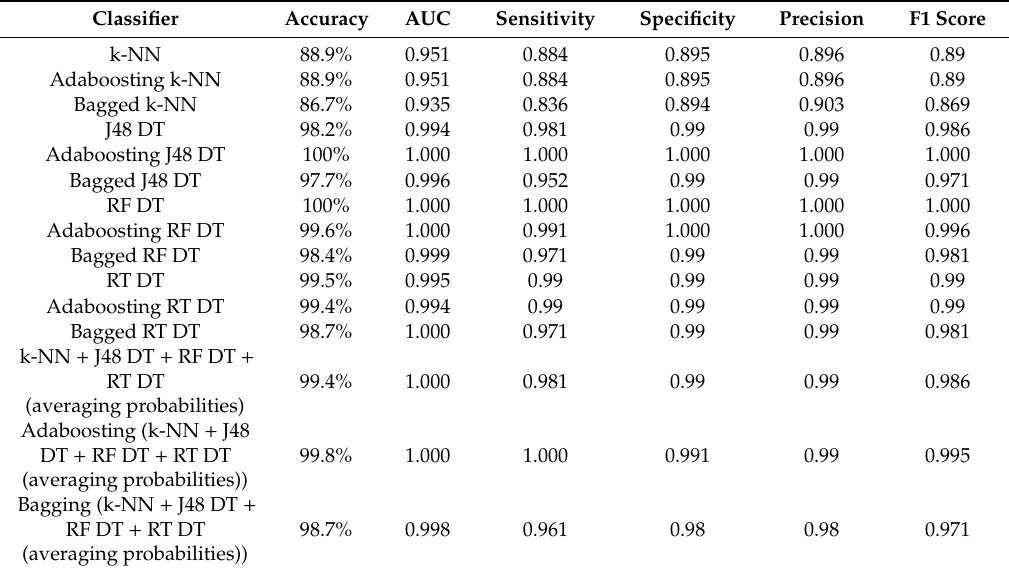
Table 2. Classification results of the four individual classifiers and the multiple classifier systems (MCS) constructed with all the four classifiers and their ensembles for the MIAS dataset.